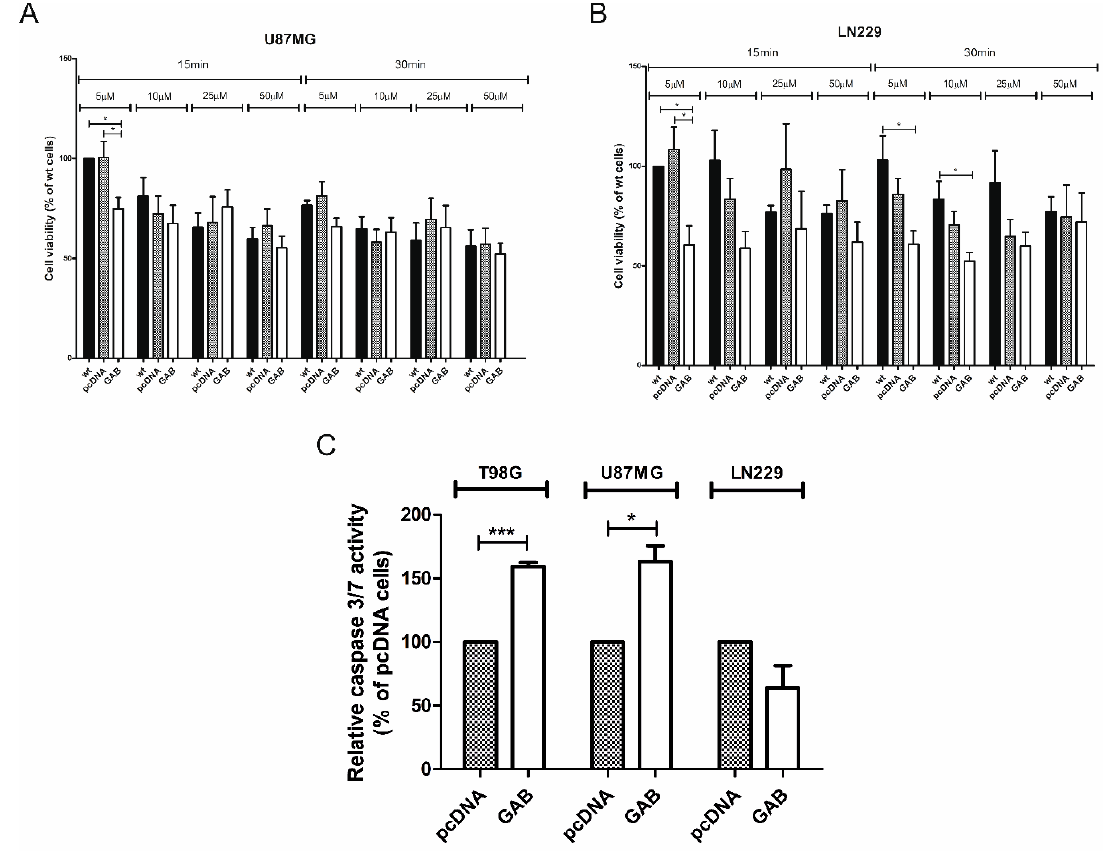
Figure 5. Transfection with the GAB sequence alters the sensitivity of cells to H 2 O 2 , inducing in some cell lines apoptosis. The sensitization of U87MG ( A ) and LN229 ( B ) cells to treatment with H 2 O 2 are shown here. The viability of wt cells or transfected with the indicated plasmids was measured by the MTT test after treatment with 5–50 µ M H 2 O 2 for 15 min and 30 min. Results are mean ± SD ( n = 3–5) expressed as a percentage of wt cells treated with 5 µ M H 2 O 2 for 15 min. * p < 0.05 versus wt and pcDNA (one-way ANOVA followed by Tukey’s test). ( C ) Transfection with GAB upon H 2 O 2 treatment induces apoptosis in T98G and U87MG cells. Apoptosis was analyzed by caspase 3/7 activity analysis in (i) TpcDNA and TGAB cells after the treatment with 200 µ M H 2 O 2 for 15 min, (ii) UpcDNA and UGAB cells after the treatment with 5 µ M H 2 O 2 for 15 min, and (iii) LNpcDNA and LNGAB cells after the treatment with 5 µ M H 2 O 2 for 15 min. Caspase-Glo 3/7 assay results are shown as a percentage of pcDNA cells. Results are mean ± SD ( n = 3–4) expressed as a percentage of pcDNA cells. * p < 0.05, *** p < 0.001 versus pcDNA (Student’s t